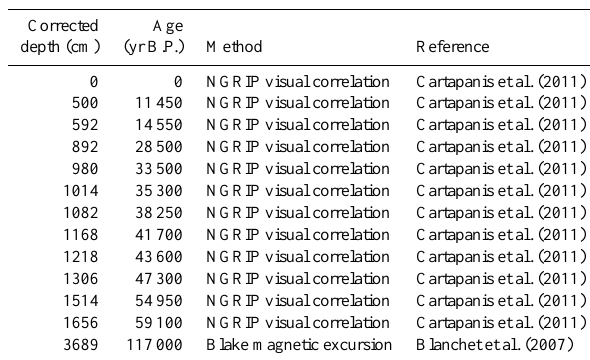
Table 1. Tie points (corrected depth in cm, age in year B.P.), method and references used to build the age model of MD02-2508 core in this